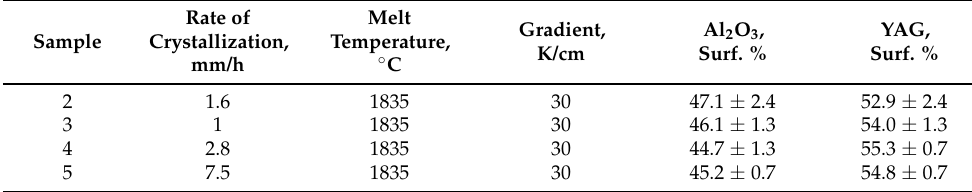
Table 1. Modes of crystallization of eutectic